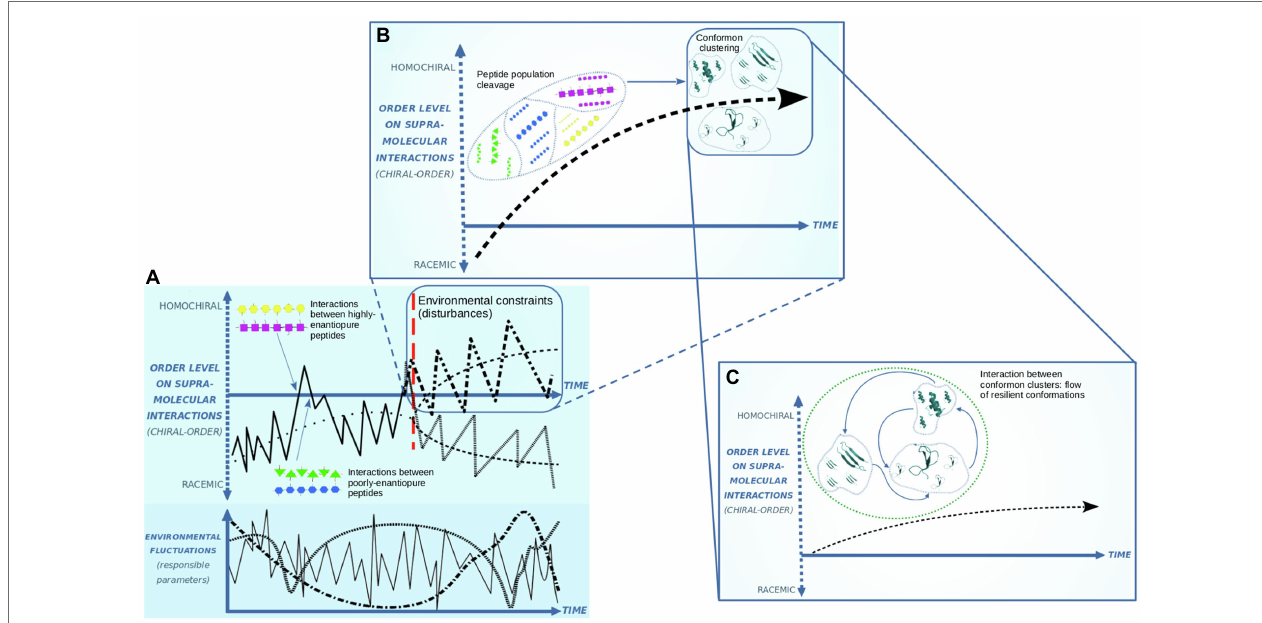
FIGURE 1 | Clustering of enantiopure peptides and chiral-asymmetric systems formation. Under far from-equilibrium-conditions, chiral asymmetry is determining supramolecular interaction rates between peptides (A) . Environmental disturbances induce the cleavage on peptide populations, clustering the equivalently enantiopure conformons (B) . Structural destabilization and conformational change induction on the conformons allow an exchange of molecular shapes between clusters (C)